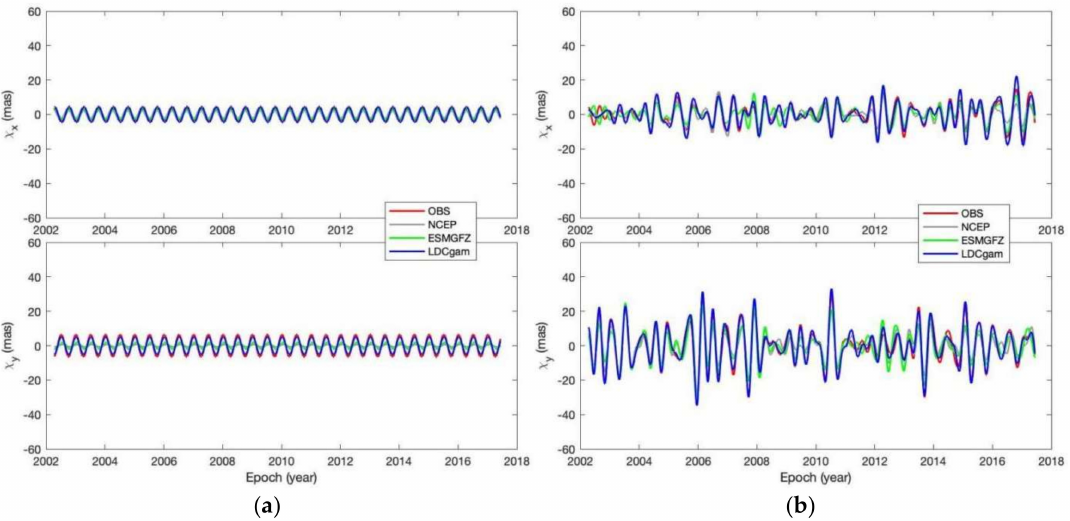
Figure 7. Semi-annual PM excitations. ( a ) Harmonic fitting according to Equation (2); ( b ) wavelet analyses based on the coif5 wavelet, as shown in Figure